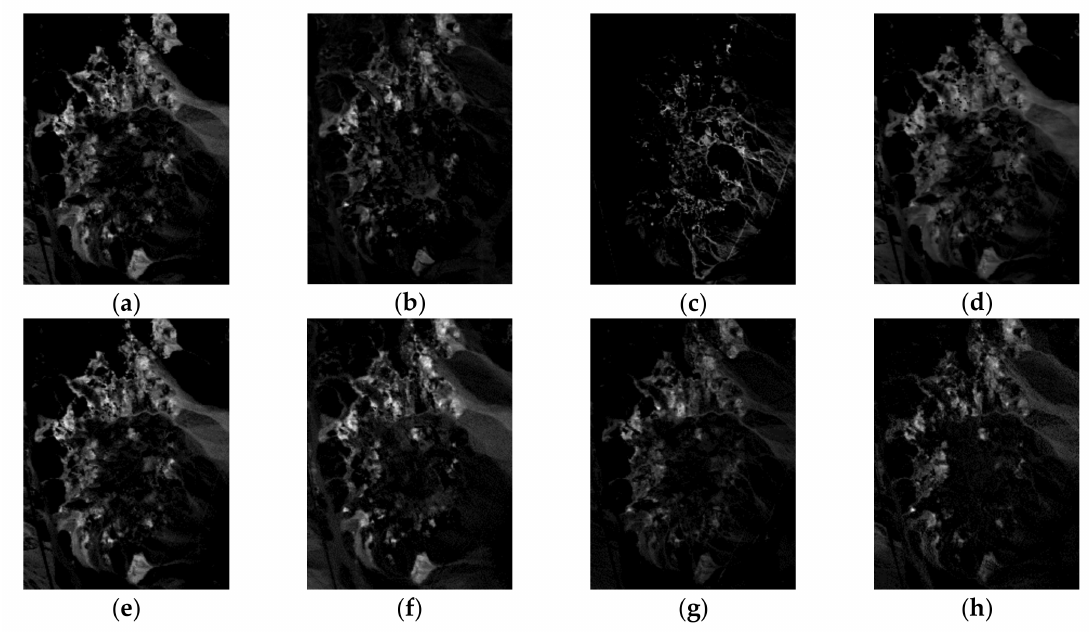
Figure 19. Kaolinite KGA: ( a ) VCA, ( b ) N-FINDR, ( c ) SGA, ( d ) C-NMF, ( e ) MVC-NMF, ( f ) ICE, ( g ) SPICE, ( h ) SPEEVD.